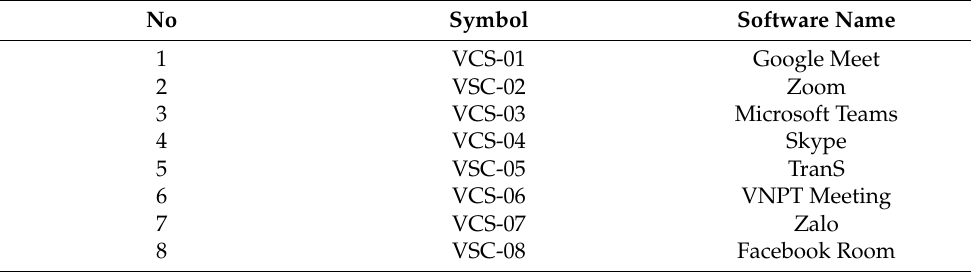
Table 3. The list of video conferencing software companies used in this study. No Symbol Software